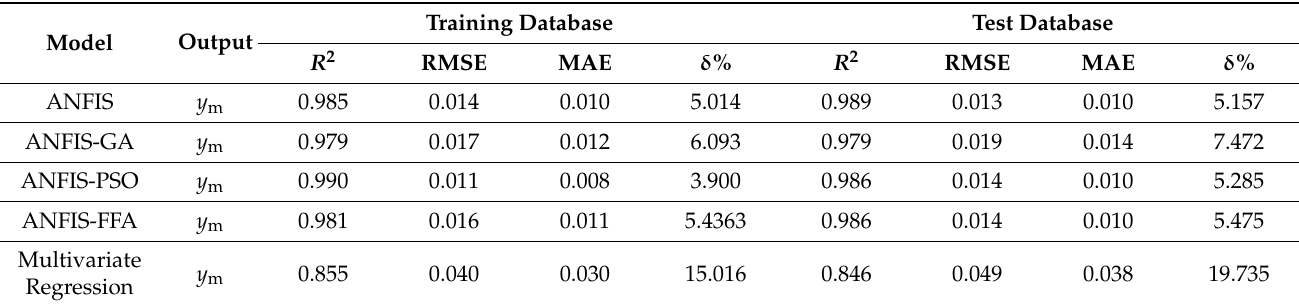
Table 6. Models’ performance evaluation for output y m